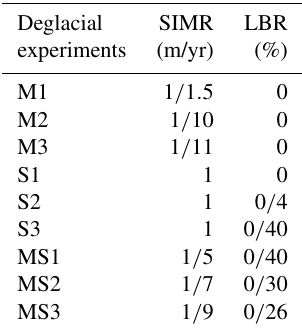
Table 2. Idealised deglacial sensitivity experiments. Sub-ice-shelf melt rate (SIMR) varies within a 0.5m/yr window around the value reported. SIMR is forced at 7500 model years, and lateral buttress- ing reduction (LBR) is forced at 8500 model years. X / Y indicates initial conditions and forced conditions, respectively. If held con- stant, one value is